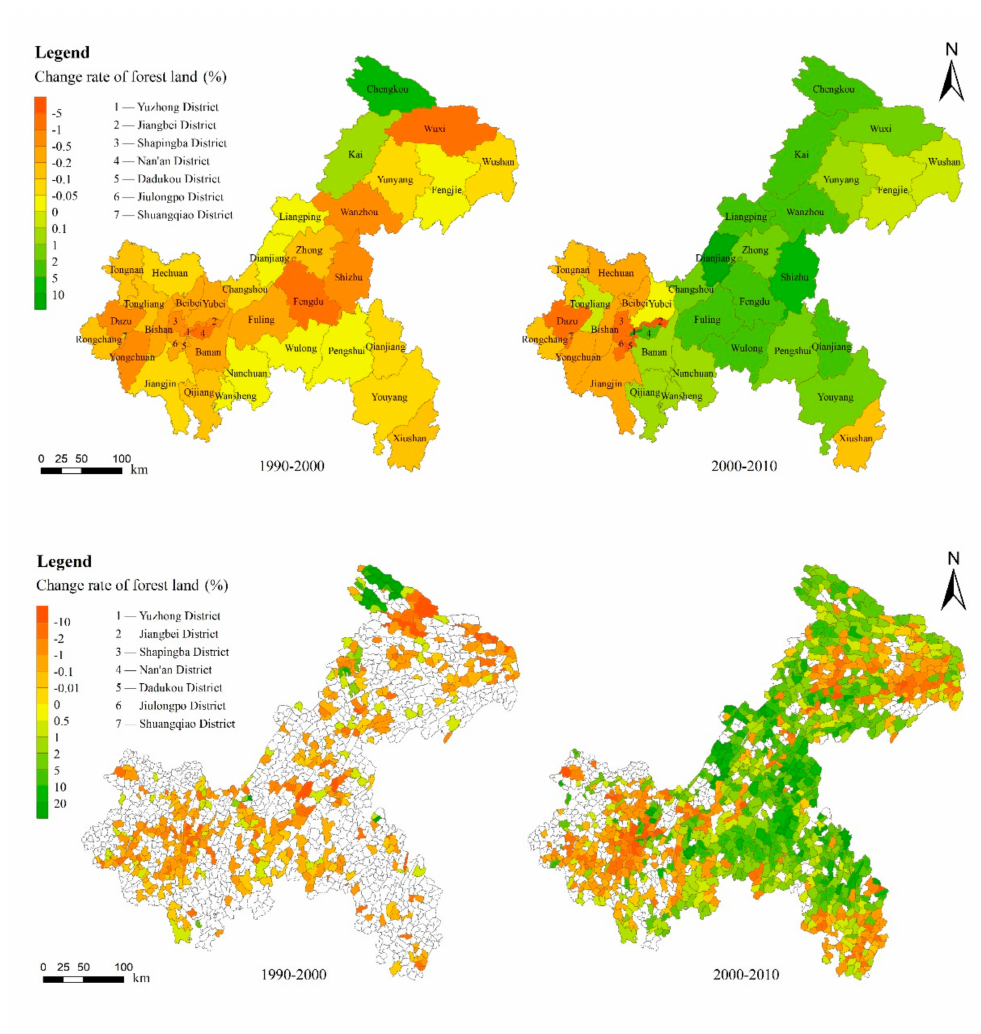
Figure 6. Spatiotemporal patterns of forest land change rate at district/county ( up ) and town/village ( down ) level in Chongqing (1990–2010); Source: edited by